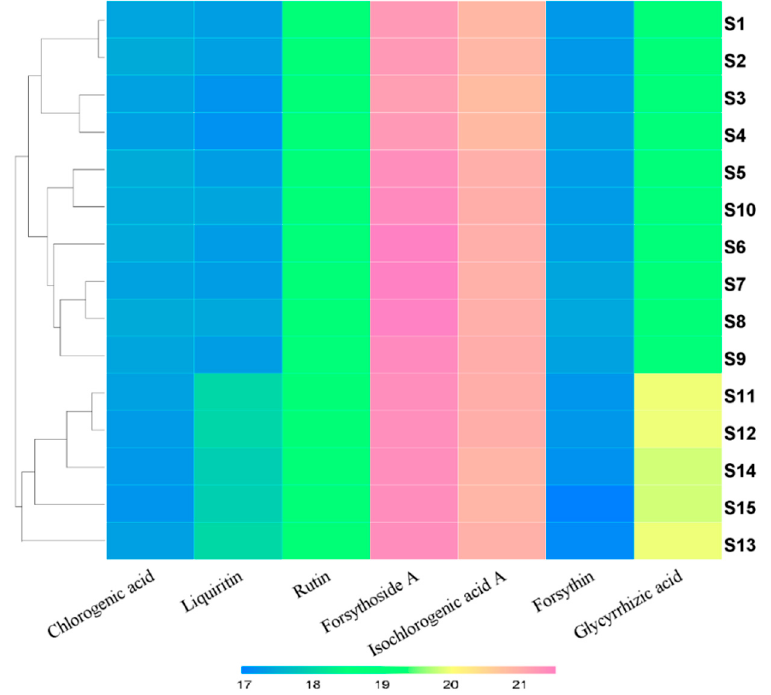
Figure 4. Heatmap of peak areas from 15 batches of samples. The HemI software was used to generate this map, and the hierarchical method was used for clustering against different samples. Peak area values were normalized by log2 transformation, and represented with different colors in the color gradation at the bottom.